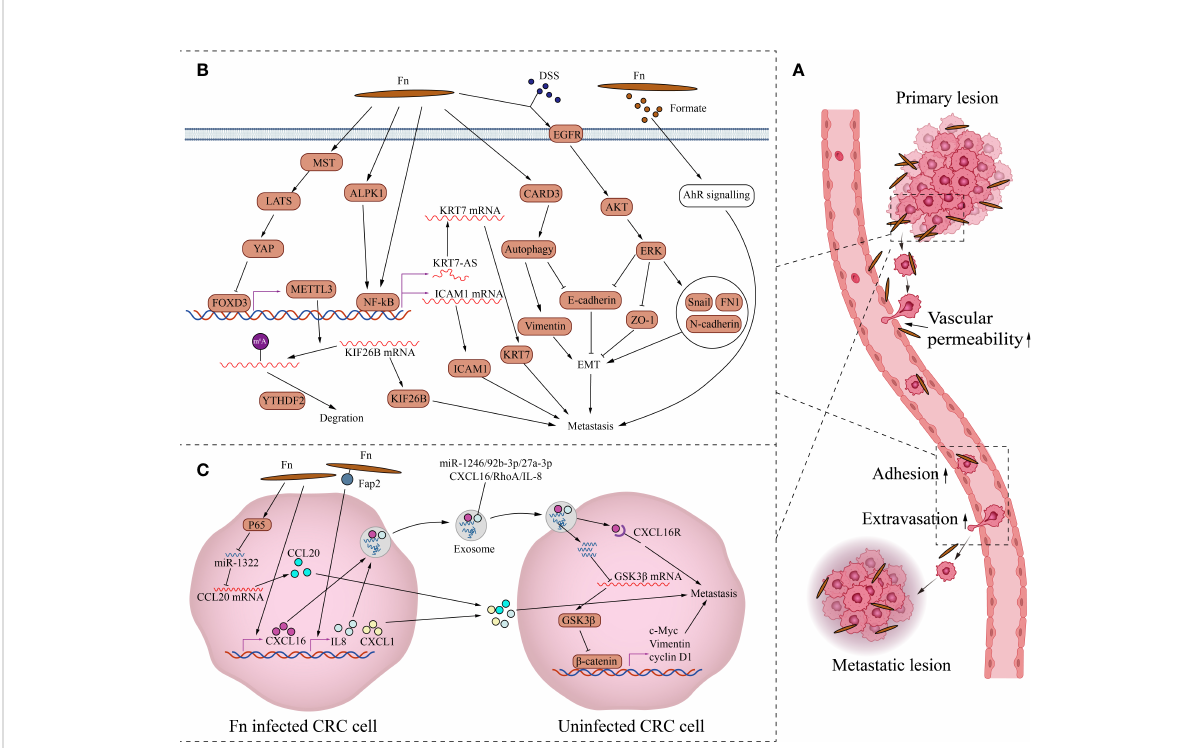
FIGURE 2 The mechanism of Fn promoting CRC metastasis. (A) This is the schematic diagram of CRC distant metastasis. Fn exists in primary and metastatic lesions. Fn infection can increase vascular permeability, CRC cells attachment to endothelial cells and extravasation to promote metastasis. (B) Fn promotes metastasis by regulating intercellular signals. Fn inhibits transcription factor FOXD3 through activating MST/LATS/ YAP axis axis. The downregulation of FOXD3 inhibits the expression of its target gene METTL3, fi nally increases the level of KIF26B by reducing the YTHDF2-dependent mRNA degradation, to promote metastasis. Fn activates NFKB through ALPK1 or other paths, Activated NFKB promotes CRC metastasis by KRT7-AS/KRT7, and also by increasing ICAM1. Fn induces epithelial mesenchymal transformation of CRC cells to promote metastasis by activating CARD3 mediated autophagy, and also by activating EGFR/AKT/ERK siganaling. Formate, metabolite of Fn promotes the metastatic dissemination by activating the AhR signal. (C) Fn promotes metastasis by activating intracellular signals. Fn infection induces the expression and secretion of cytokines CXCL1 and IL-8, which promote metastasis of non-Fn-exposed CRC cells. Fn upregulates CCL20 by activating NF- k B/miR-1322 signaling, and promotes metastasis of CRC. Fn infection increases CRC cells the release of exosome full of miR- 1246/27a-3p/92b-3p and CXCL16/IL-8/RhoA to promotes metastasis of other CRC